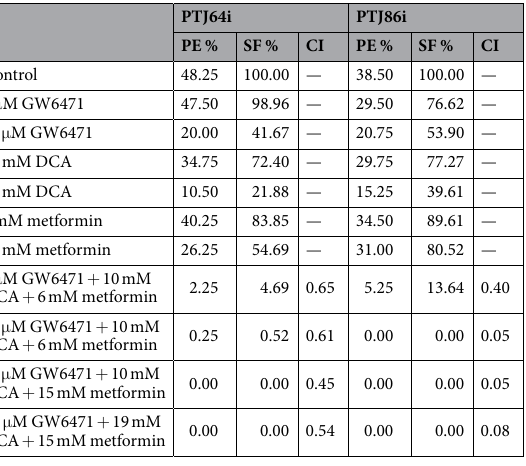
Table 1. Plating efficiency (PE), surviving fraction (SF) and combination index (CI) values in PTJ64i and